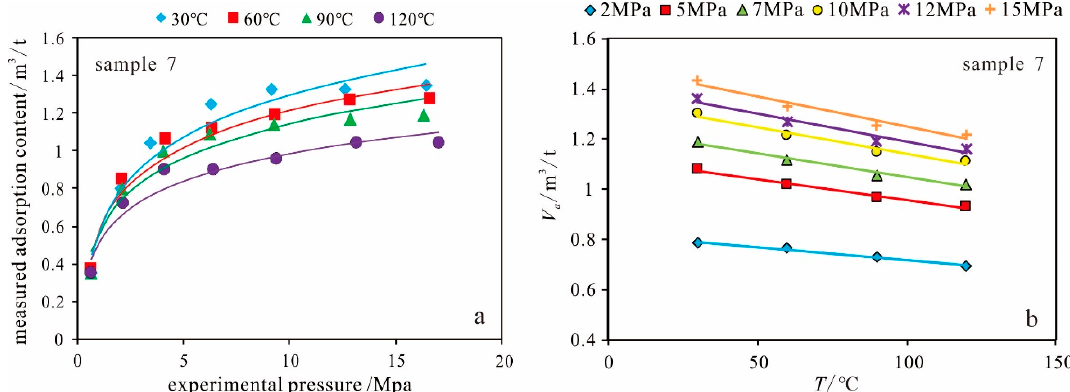
Figure 21. Influence of temperature on V a . ( a ) Isothermal adsorption curves of sample 7; ( b ) linear relationship between V a and temperature.